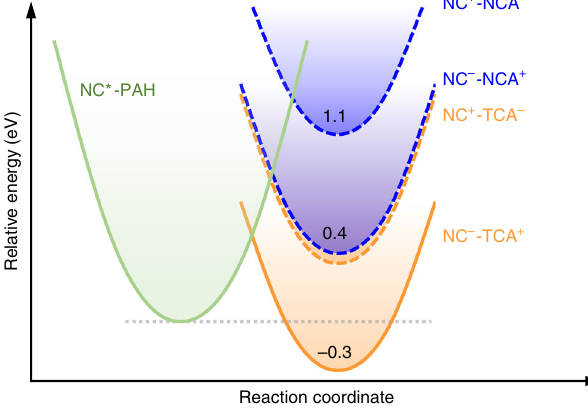
Fig. 2 CT energetics. The parabolas represent the reactant state (NC*- PAH) and the various CT product states drawn on a continuous reaction coordinate mainly contributed by the surrounding medium. The lowest energies of the CT states with respect to that of the NC*-PAH state are indicated. Note that the curvatures of these parabolas and the horizontal displacements between them are not for quantitative use, because the reorganization energies for NCA and TCA molecules should be different.